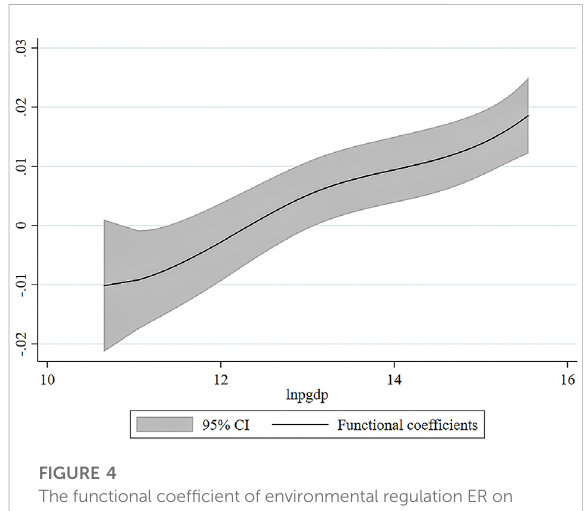
FIGURE 4 The functional coef fi cient of environmental regulation ER on agricultural GTFP.